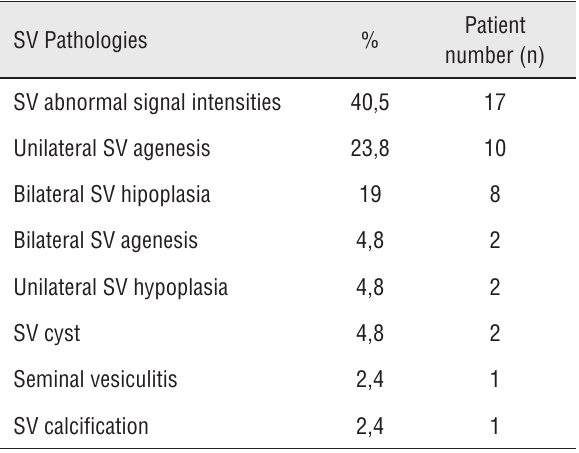
Table 6 - Congenital and acquired sv